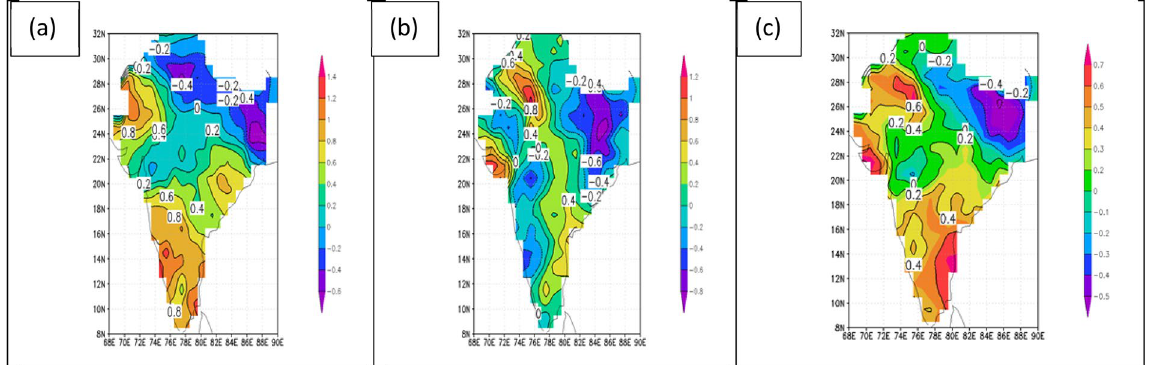
Figure 4. Difference in decade means of daily temperature (C) for the post-monsoon period of January 1 to March 31. Values are for the decade of the 2000s minus the decade of the 1950s for ( a ) maximum temperature, ( b ) minimum temperature, and ( c ) mean temperature. Figures are generated using GrADS 2.2.0 (http://cola.